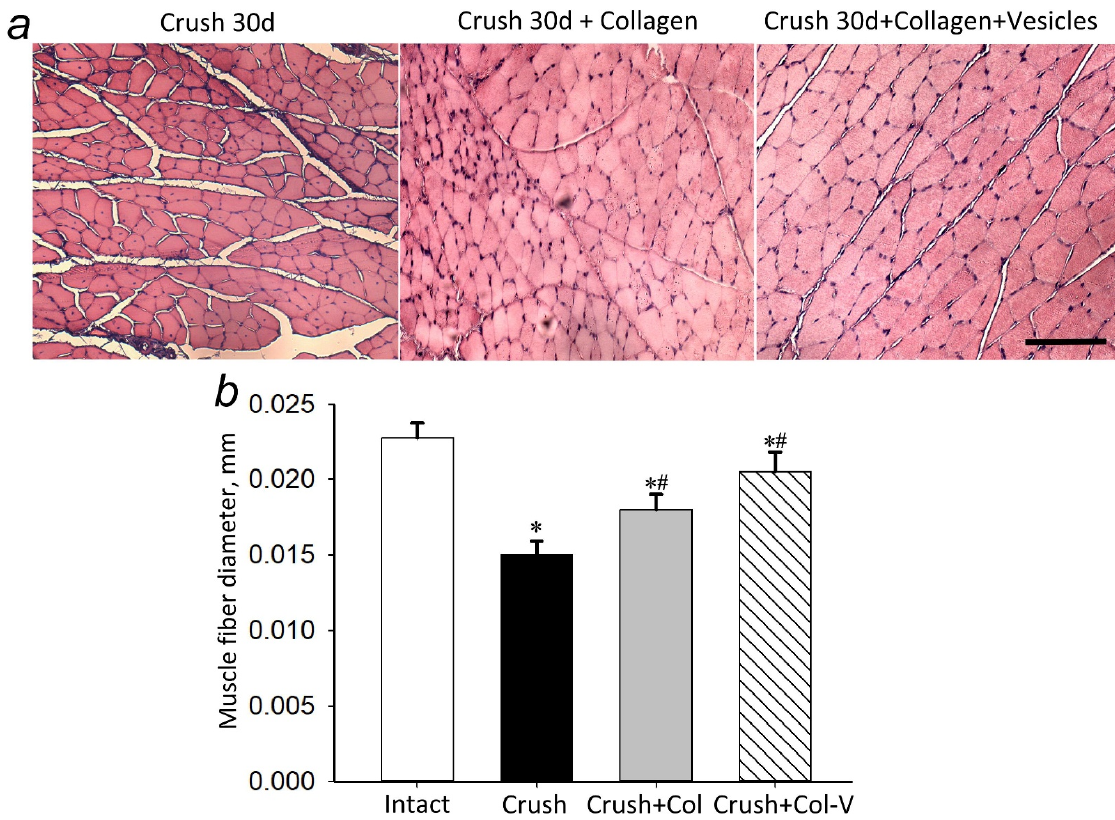
Figure 3. Changes in the diameter of muscle fibers of the gastrocnemius muscle of the injured limb 30 days after sciatic nerve crushing. ( a ) View of muscle fibers 30 days after sciatic nerve crushing (Crush 30 d), application of collagen gel (Crush 30 d+Collagen), and collagen preparation of vesicles (Crush 30 d+Collagen+Vesicles) one hour post-injury. Hematoxylin-and-eosin staining. Scale: 100 µm. ( b ) Changes in the diameter of muscle fibers of the gastrocnemius muscle 30 days after sciatic nerve crush (Crush), application of collagen gel (Crush+Col), and collagen preparation of vesicles (Crush+Col-V) one hour post-injury, in mm. M ± SEM; n = 8 (the number of animals in each experi- mental group); * p < 0.05 compared to the group with crushing without treatment (Crush); # p < 0.01